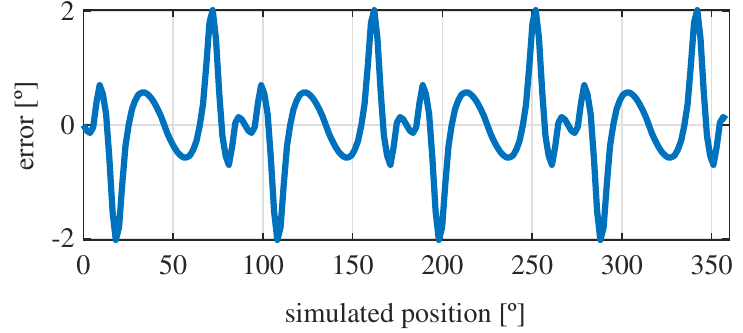
Figure 21. Toroidal four-slot skewed resolver position error.